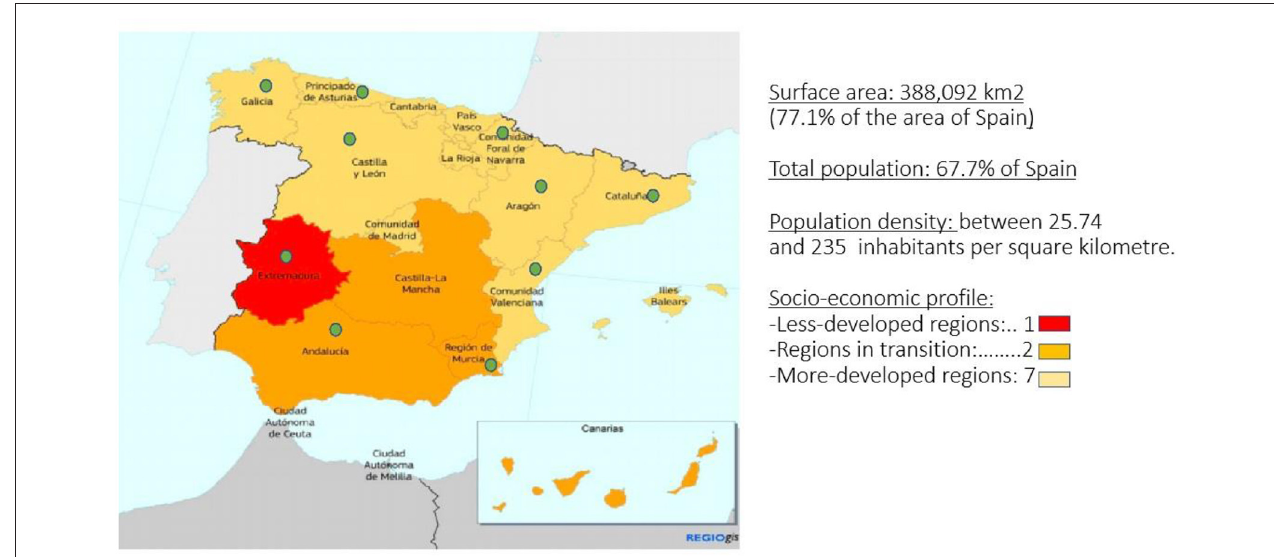
FIGURE 1 | Map of Spanish regions participating in the case study. Source: Prepared by the authors from official data.